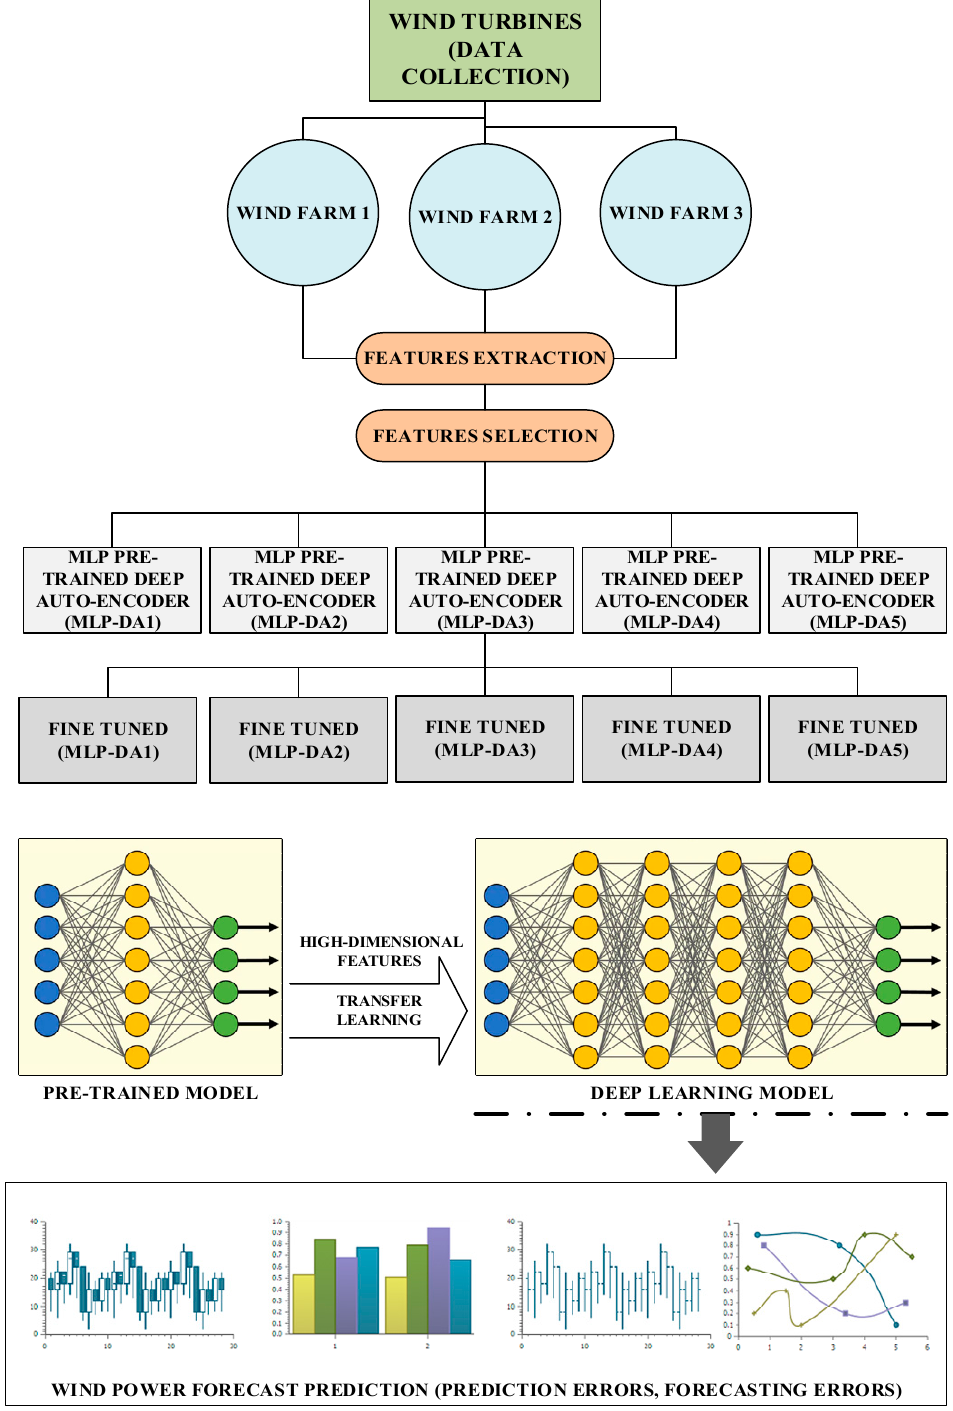
Figure 1. Overall Structure and Work Flow of the Proposed Research Framework to Forecast Wind